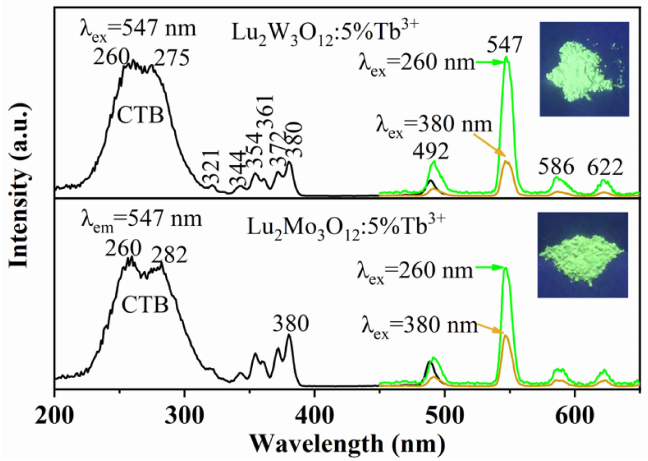
Figure 8. PL excitation and emission spectra of 5 mol%Tb 3+ -doped Lu 2 W 3 O 12 and Lu 2 Mo 3 O